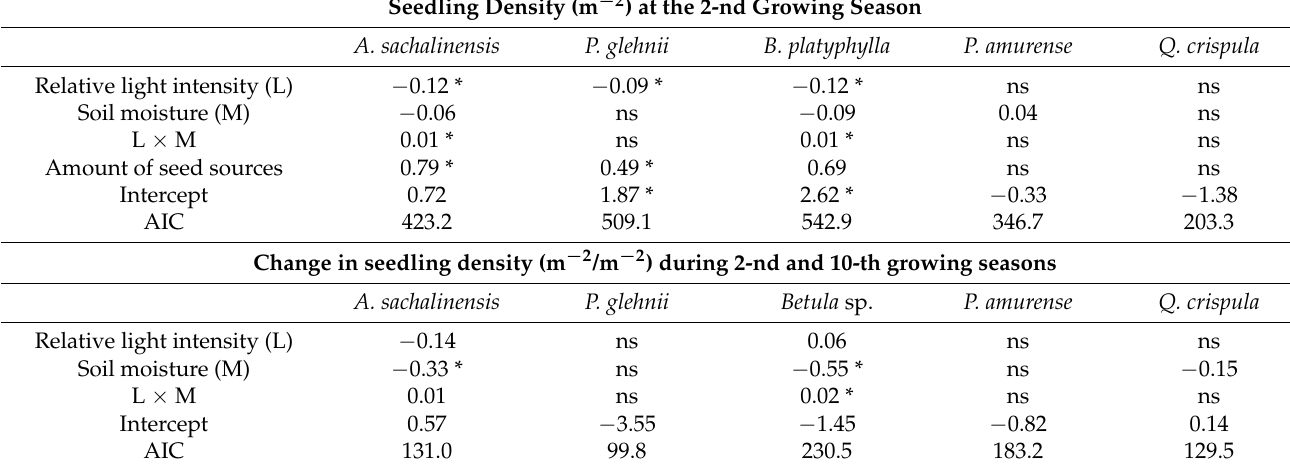
Table 4. Summary of the generalized linear model to examine seedling density at 2-nd growing season and change in the density during 2-nd and 10-th growing seasons of the five major tree species grown on the microtopographies. The coefficients for the variables selected in the model are shown.